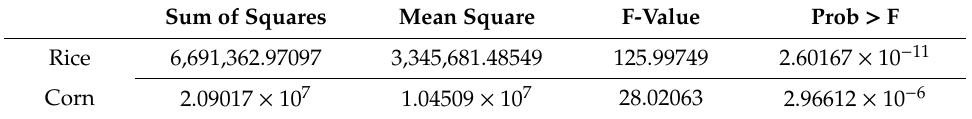
Table 11. Results of the significance tests for the equations of the integrated energy consumption regression. Sum of Squares Mean Square F-Value Prob > F Rice